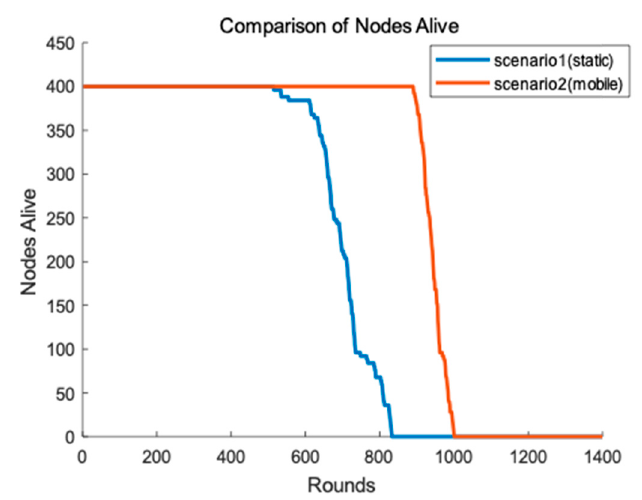
Figure 11. Lifetime of two different scenarios.